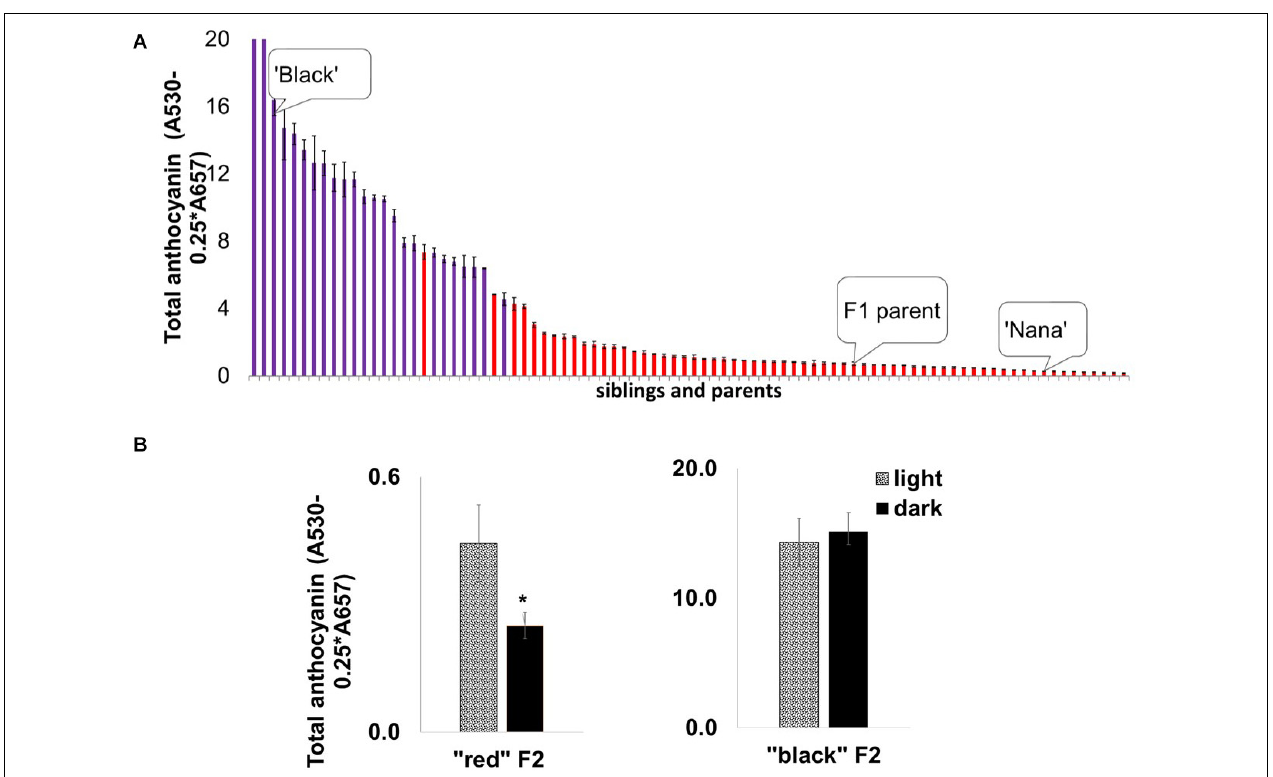
FIGURE 5 | Segregation of anthocyanin in mature fruit peels and the effect of depletion of light on peel color development in the ‘Nana × Black’ F 2 population. (A) Distribution of total anthocyanin amount in the F 2 progeny ( n = 82) for “black” peel (purple columns) and “red” peel (red columns). The parents, ‘Black’ and ‘Nana’ and the F 1 offspring whose self-pollination created this F 2 population are marked. Each column represented in the graph is an average of three extracts ± standard error. (B) Effect of light deprivation on “red” and “black” representatives from the F 2 population: Total amount of anthocyanin in the peel of fruits developed in the dark (covered) compared with the control (light, uncovered fruits). Asterisk indicates a statistically significant difference ( p < 0.05) analyzed by Wilcoxon/Kruskal–Wallis test (rank sums) and by non-parametric comparisons probability ( F =